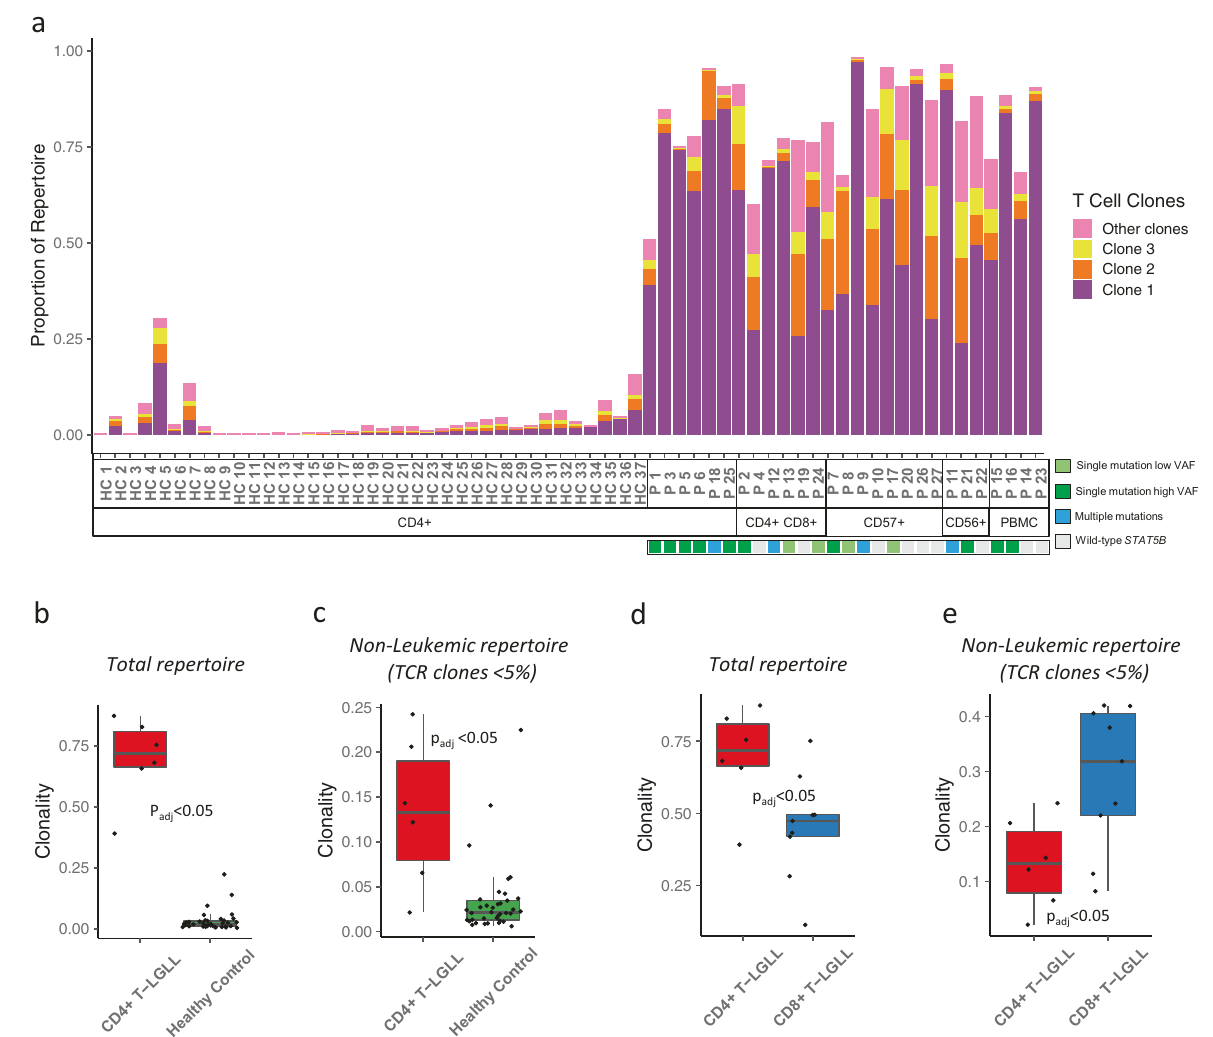
Fig. 4 Clonal expansions in CD4 + T-LGLL and comparison of the TCR β repertoires between the CD4 + T-LGLL and healthy samples. a The ten most expanded clones as proportion of total repertoire from all samples are shown. The top 3 clones are shown in individual colors while the sum of the rest (clones 4 – 10) is shown in one color. The cell isolation method (CD4, CD4 CD8, CD57, CD56, or non-selected PBMC) of the analyzed cell population and the mutational STAT5B status of the patients are given below the sample numbers. b Total CD4 + repertoire clonality as normalized Shannon – Wiener clonality index from CD4 + T-LGLL (patient samples puri fi ed for CD4, n = 6) and CD4 + cells from healthy controls ( n = 37). c Non-leukemic CD4 + repertoire clonality (selecting the CD4 + T-LGL clones with a size <5%) as normalized Shannon – Wiener clonality index from CD4 + T-LGLL (patient samples puri fi ed for CD4, n = 6) and CD4 + cells from healthy controls ( n = 37). d Total repertoire clonality as normalized Shannon – Wiener clonality index from CD4 + T-LGLL (patient samples puri fi ed for CD4, n = 6) and CD8 + cells from CD8 + T-LGLL (patient samples puri fi ed for CD8, n = 9). e Non-leukemic repertoire clonality (selecting the CD4 + T-LGL clones with a size <5%) as normalized Shannon – Wiener clonality index from CD4 + T-LGLL (patient samples puri fi ed for CD4, n = 6) and CD8 + cells from CD8 + T-LGLL (patient samples puri fi ed for CD8, n = 9). All p -values were calculated with a Mann – Whitney test and corrected with STAT5B mutations with different VAFs (Y665F: 32% and V712E: 11%) (Fig. 1 and Table 1). This suggests possible clonal evolution and the presence of different genetic lesions in individual cells bearing the same TCR. CD4 + T-LGLL clonotypes are predominantly restricted to between 8.24 × 10 − 5 – 2.59 × 10 − 5 ) (Supplementary Table 5, individual patients Fig. 5a). We further looked for the presence of the CD4 + To understand whether the 59 identi fi ed CD4 + T-LGLL clono- types (Supplementary Table 4) could be a result of convergent evolution, we examined if these clones were shared between patients. In concordance with what has been reported before in CD8 + T-LGLL [14], none of the patients had the same TCR rearrangement in their main leukemic CD4 + T-LGLL clonotypes (Fig. 5a). However, 25% (15/59) of T-LGLL clonotypes were found